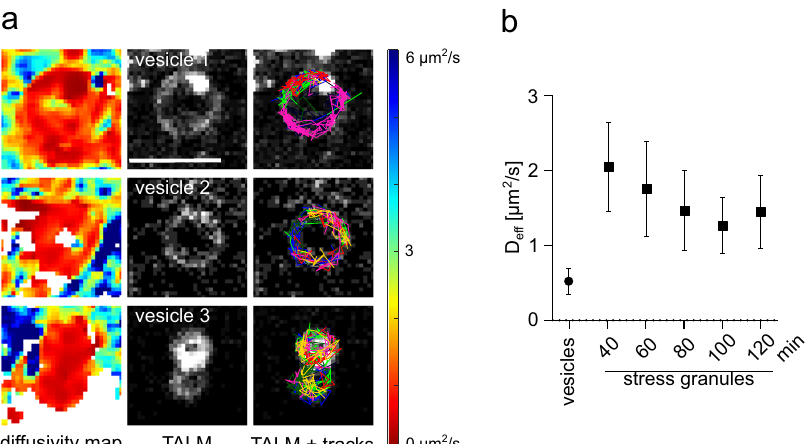
Fig. 8 | Tracking and localization microscopy (TALM) and displacement map- ping(DM)analysisofvesicularstructures.a DM(left)andTALM(middle)images showing exemplary vesicular structures observed within the cytoplasm. Selected TDP-43 Halo tracks overlayed on top of the TALM image (right) show con fi ned movement along the outline of the exemplary vesicles. Scale bar 1 µ m, n =9. TDP- 43 Halo mobilityisdisplayedinarangeof0 µ m 2 /s(red)to6 µ m 2 /s(blue). b Diffusivity analysis of TDP-43 Halo molecules localized within the vesicular structure show a